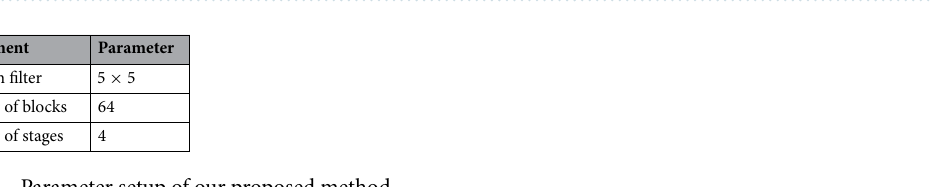
Figure 10. Visual analysis of two detected results ( a ) before and ( b ) after adding the mask mechanism. Best viewed in zoom and color.